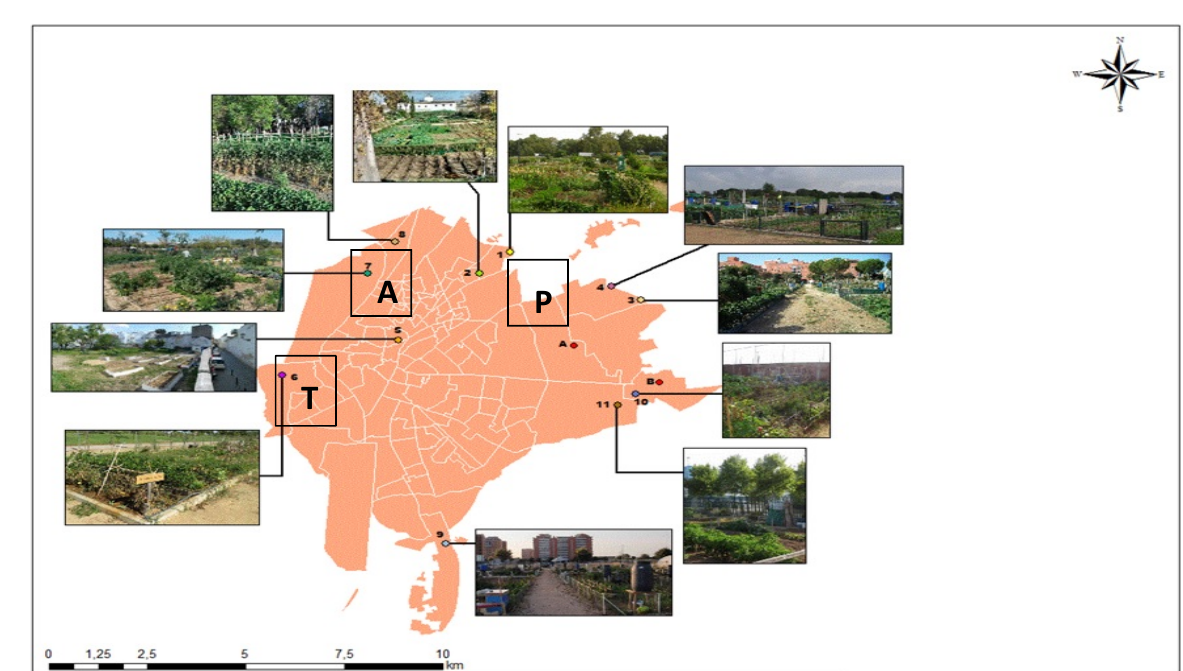
Figure 1. Urban gardens in the city of Seville selected for sampling. P, Pino Montano; A, Alamillo; T, Vega de Triana.